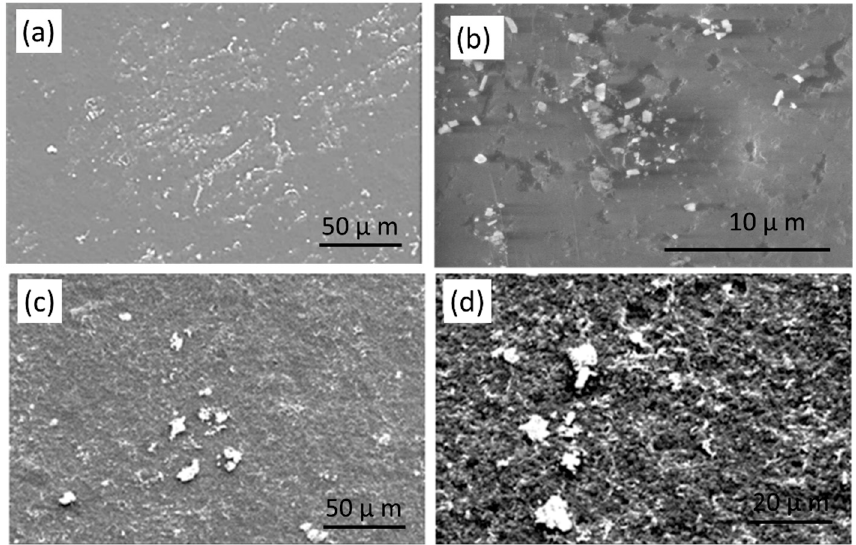
Figure 4. Low and high magnification SEM images of LDPE / HIPS composites loaded with TWP: ( a , b ) 2 wt %; and ( c , d ) 10 wt %.